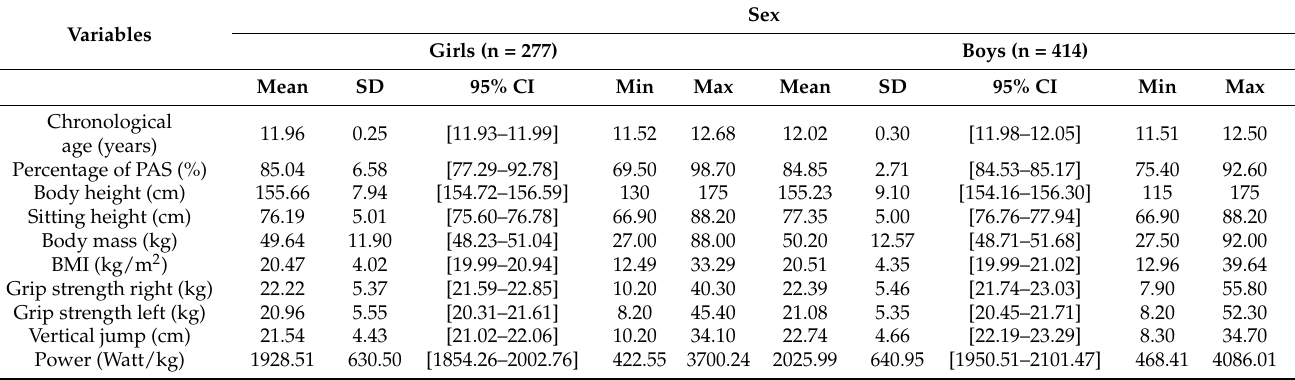
Table 1. Descriptive statistics (minimum, maximum, mean, and standard deviation) of the chronolog- ical variables, anthropometric profile, and physical fitness tests by sex